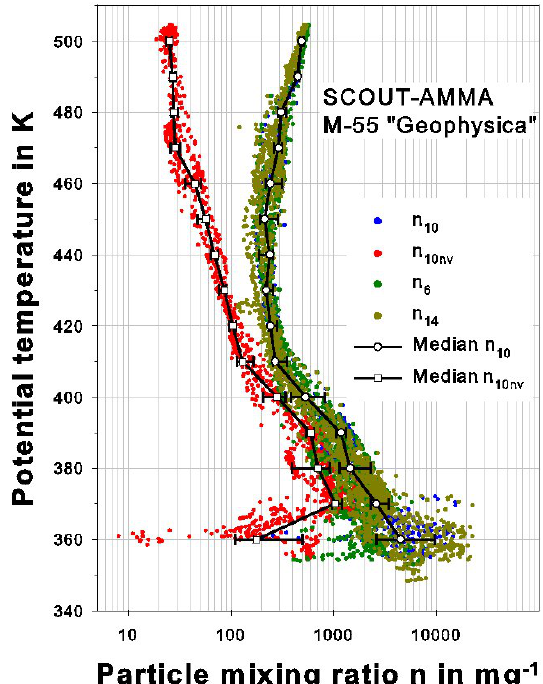
54 Fig. 5. Vertical profiles of ambient particle number mixing ratios n i from all of the M-55 “Geophysica” local flights out of Oua- gadougou (Burkina Faso) in August 2006. The small points are 15s averages and the open symbols represent medians of 10K bins with 25% and 75% percentiles. The red points are the values for non-volatile particles ( n 10nv ) . The cold point tropopause during SCOUT-AMMA was roughly between 365 and